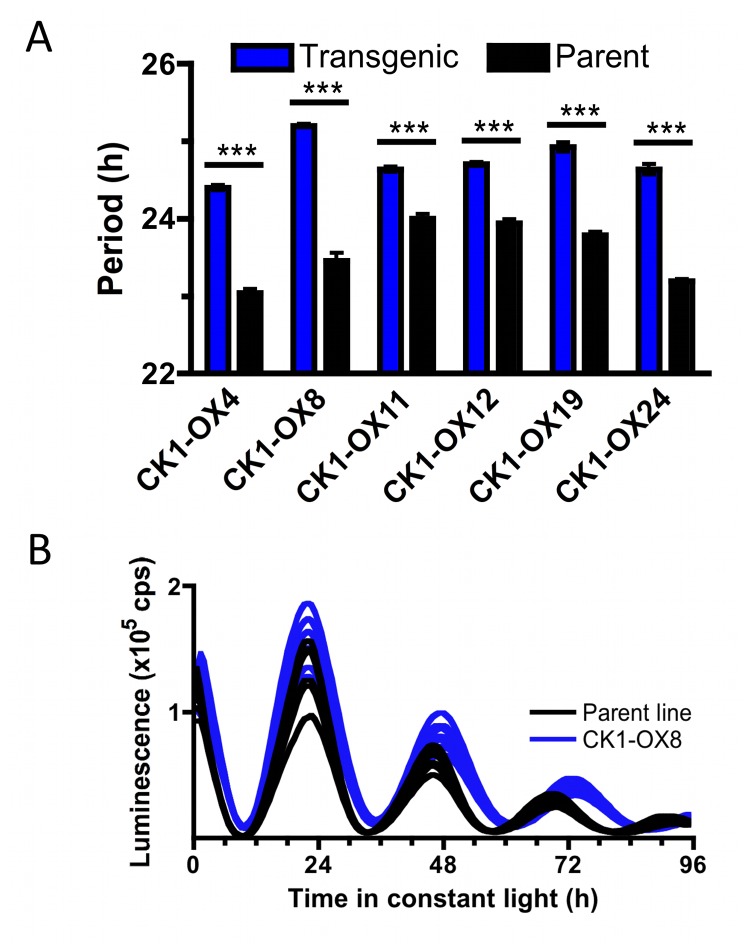
Long period phenotype induced by CK1 overexpression.(A) Free-running period was analysed by bioluminescent imaging in 6 independent transgenic lines overexpressing CK1 in the CCA1-LUC background. Lines were compared against the parent line in identical plate positions. In all cases, a significantly (p<0.001) long circadian period was observed (n=8). (B) Example traces of luminescent lines overexpressing CK1 (CK1-OX8, blue) compared to the parent line CCA1-LUC (black) in constant light.